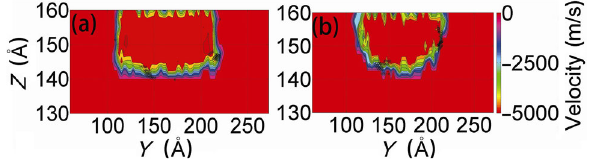
Fig. 9 The thickness variation curve with time of the water film confined between the cluster and the silicon substrate: (a) Pos20; (b)